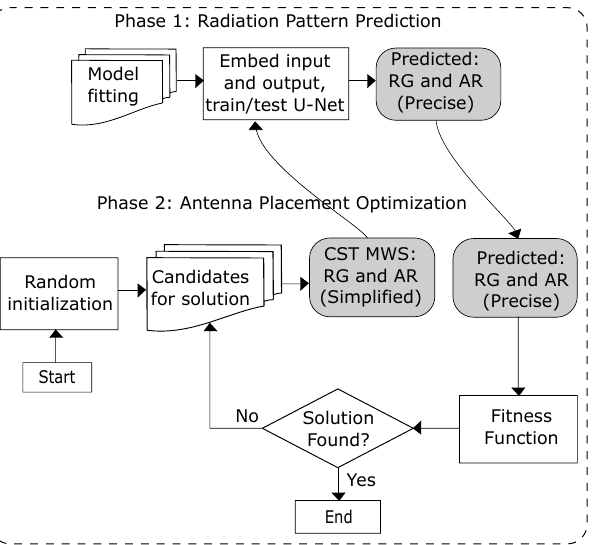
Figure 3. Overview of antenna placement optimization with the machine learning model U-Net to predict the radiation pattern.